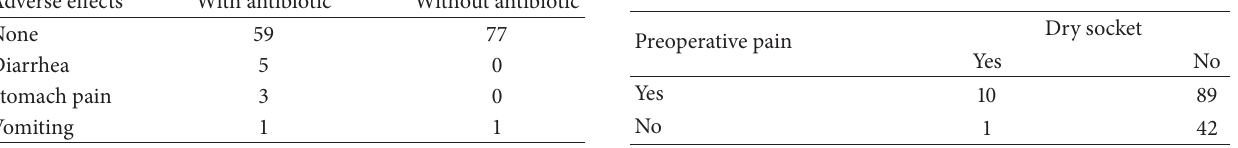
Table 4: Association of preoperative pain with dry